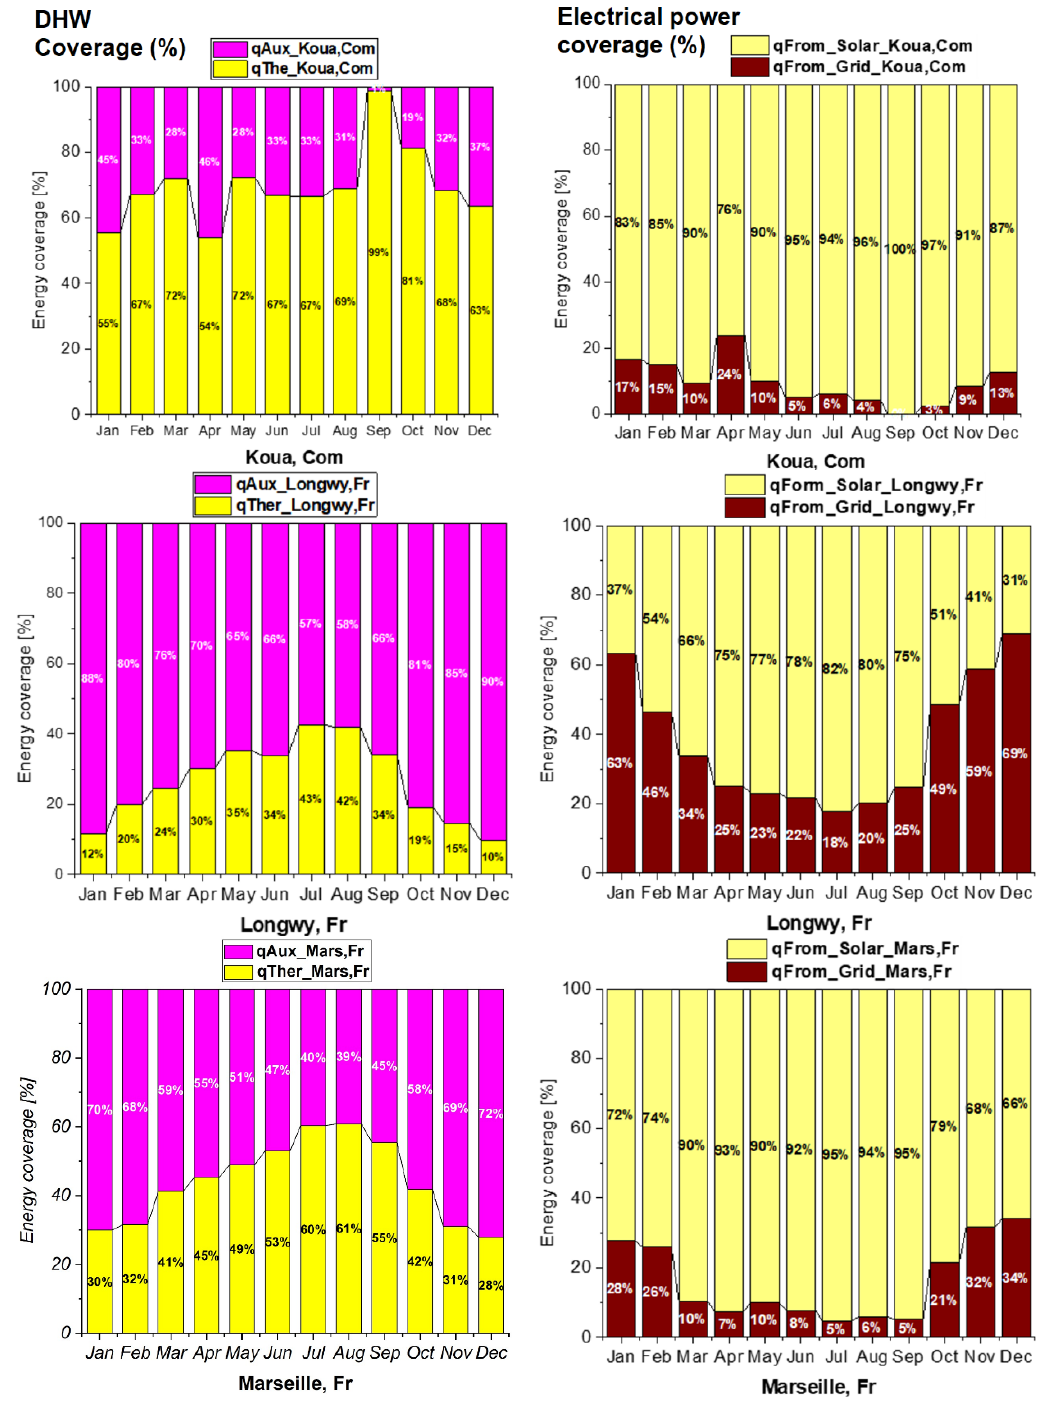
Figure 11. Solar coverage for DHW and electricity loads.